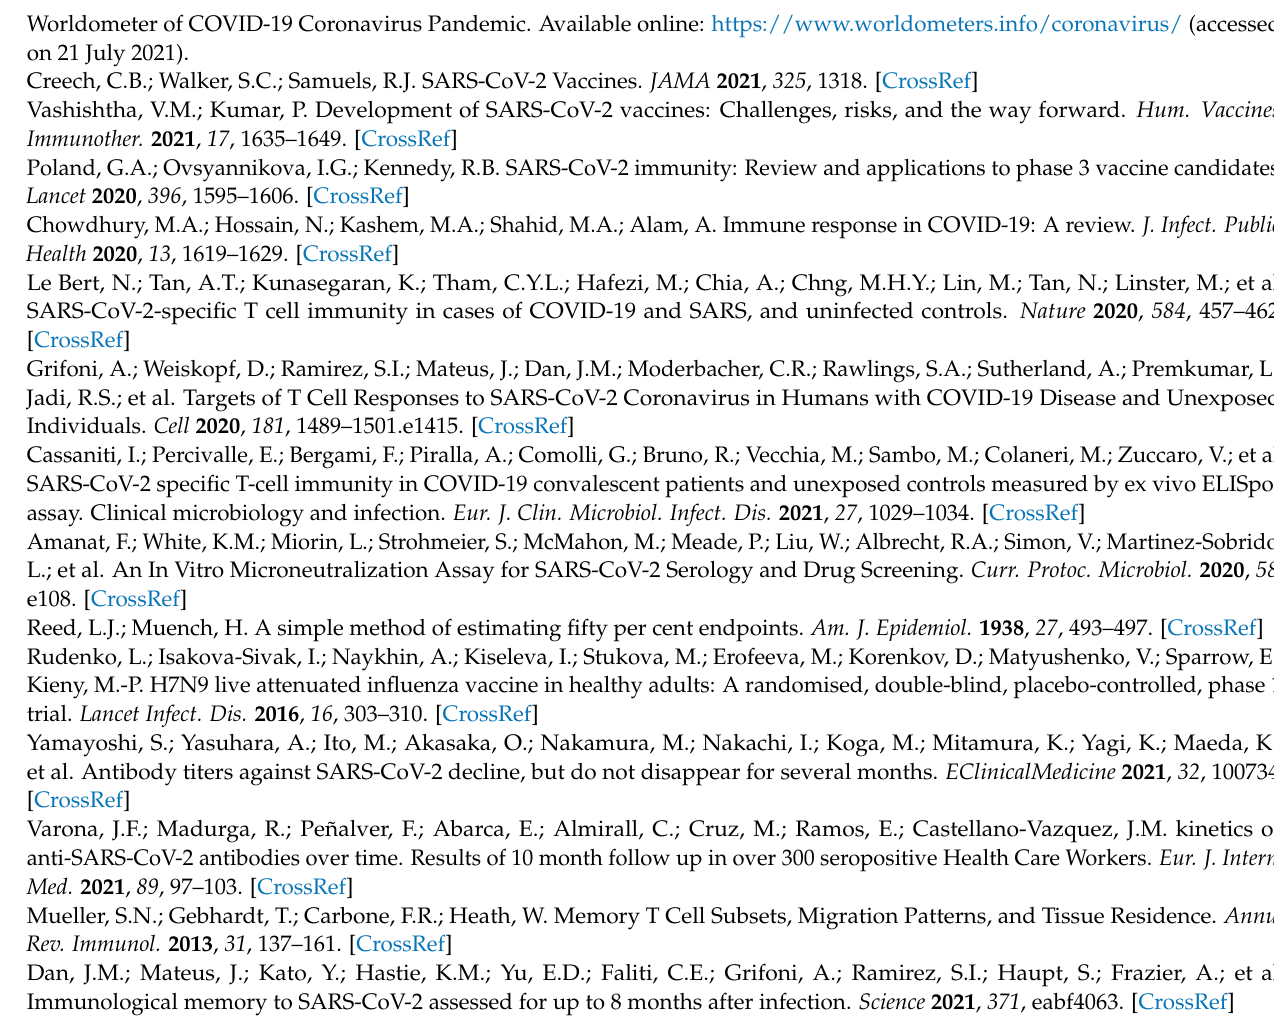
Table S1: Demographic characteristics of the study